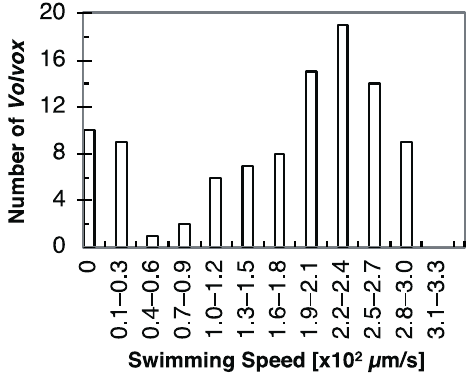
Figure 5. Swimming speed distribution of Volvox carteri calculated by the equation in Section 2.2. The horizontal axis is the swimming speeds and the vertical axis is the frequency of the population.